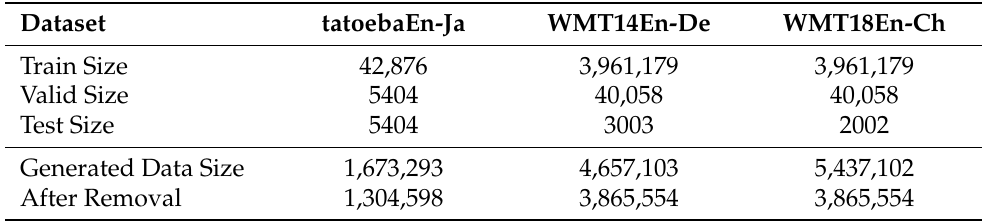
Table 1. The amount of training, validation and test data, and the amount of data to be added to the training data by GPT-2